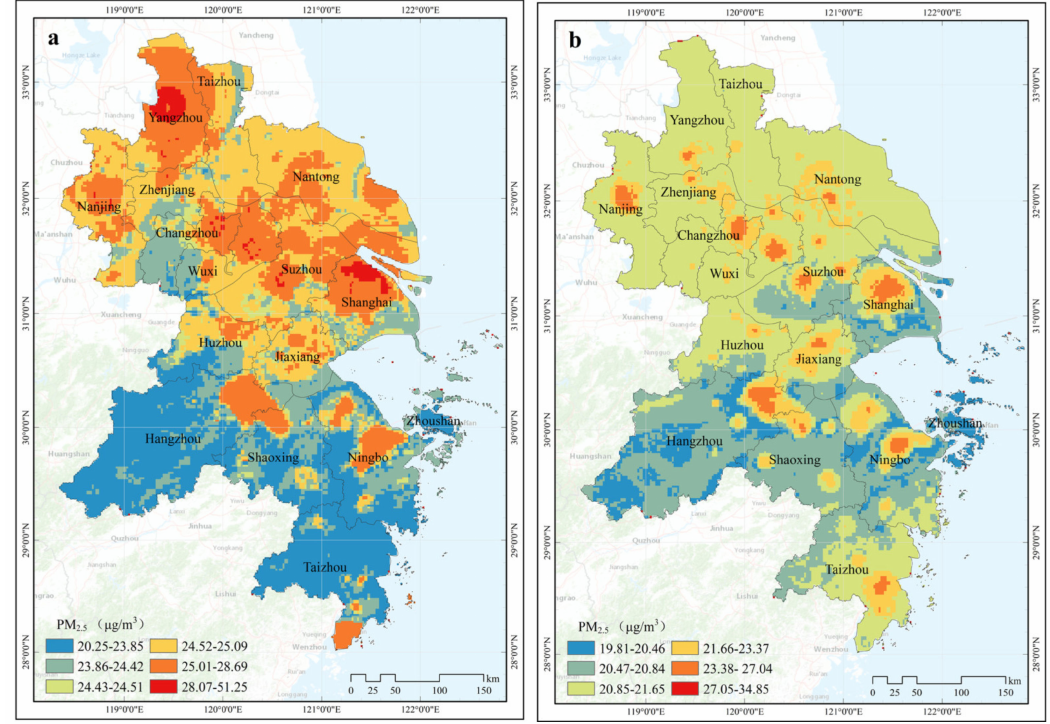
Figure 6. Spatial distributions of estimated PM 2.5 concentrations in Yangtze River Delta ( a ) The same period in 2019; ( b ) During